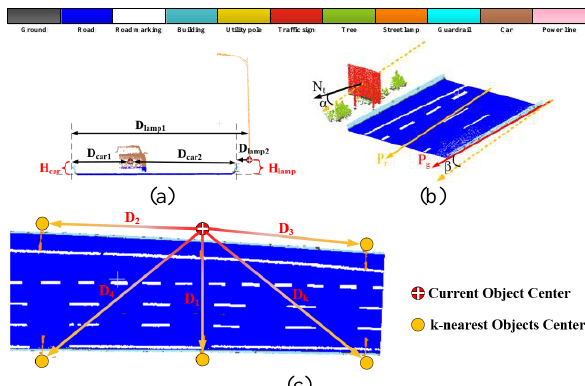
Figure 7. The Context-based features of different kinds of objects: (a) Relative Position Relation, (b) Relative Direction Relation, and (c) Spatial Distribution Pattern.